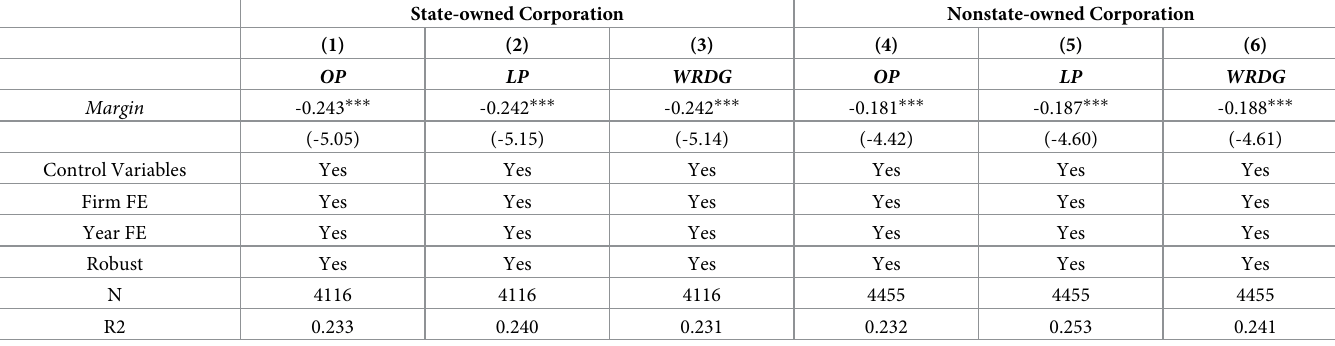
Table 13. Robustness test—regression by property